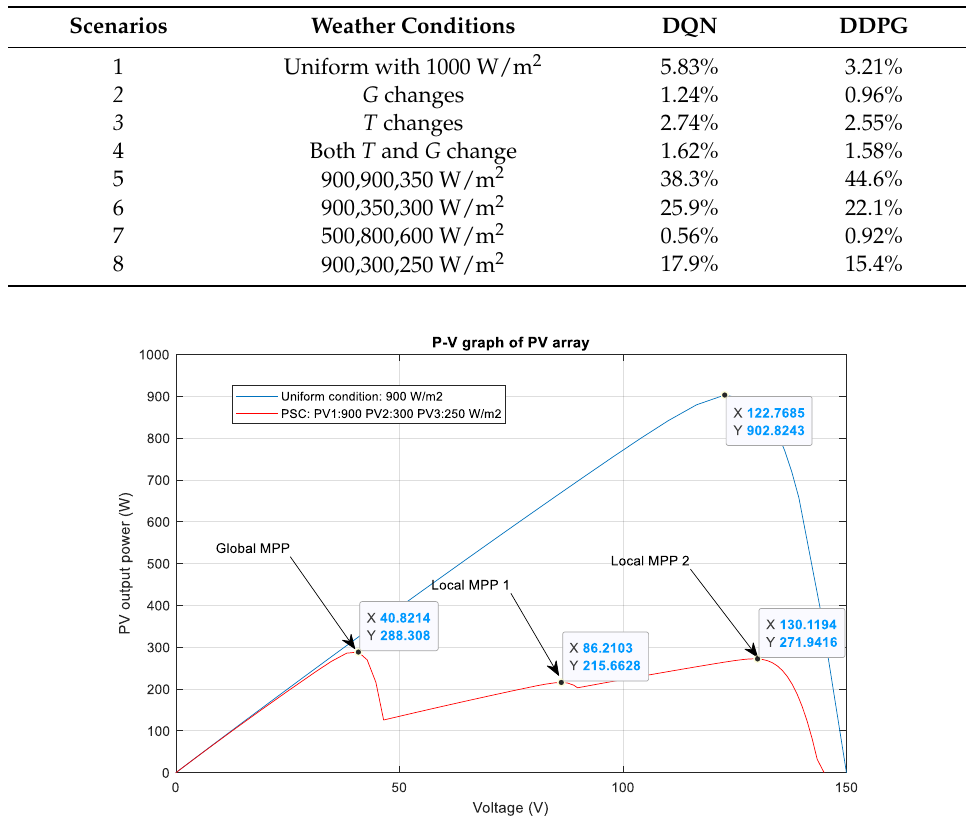
Figure 18. PV power under PSC with a local maximum power point (MPP) tracking. Table 3. MPPT tracking efficiency of the proposed methods under various weather conditions compared to P&O. Scenarios